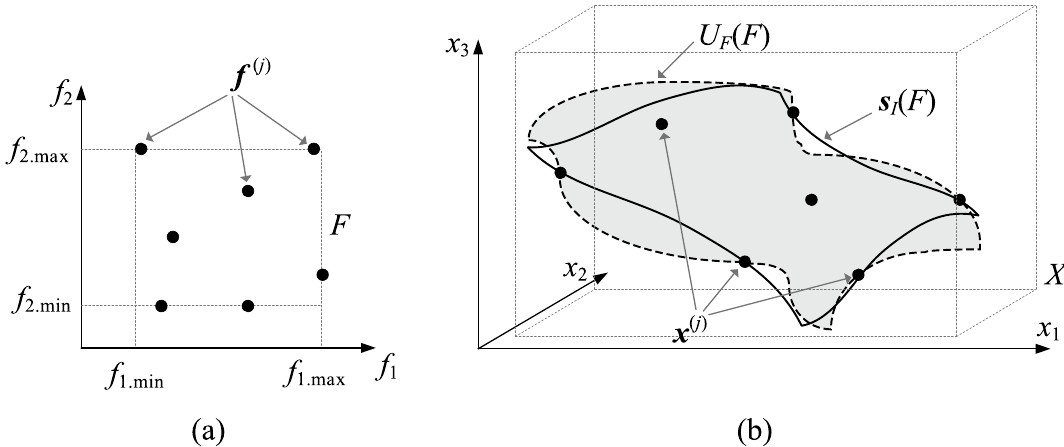
Figure 1. Basics of confined modeling 68 : ( a ) the objectives’ space F , ( b ) design space X (black circles mark the trial points, grey surface indicates the manifold of optimum designs U F ( F )). The image of the first-layer metamodel s I ( F ) yields a rough assessment of the manifold, so it needs to be outstretched to encompass entire U F ( F